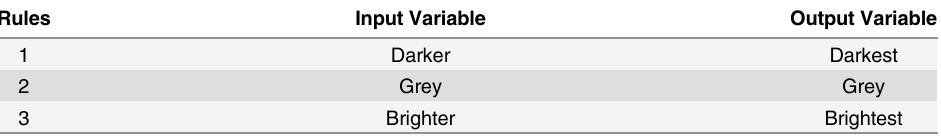
Table 3. Fuzzy rule base for contrast adjustment.